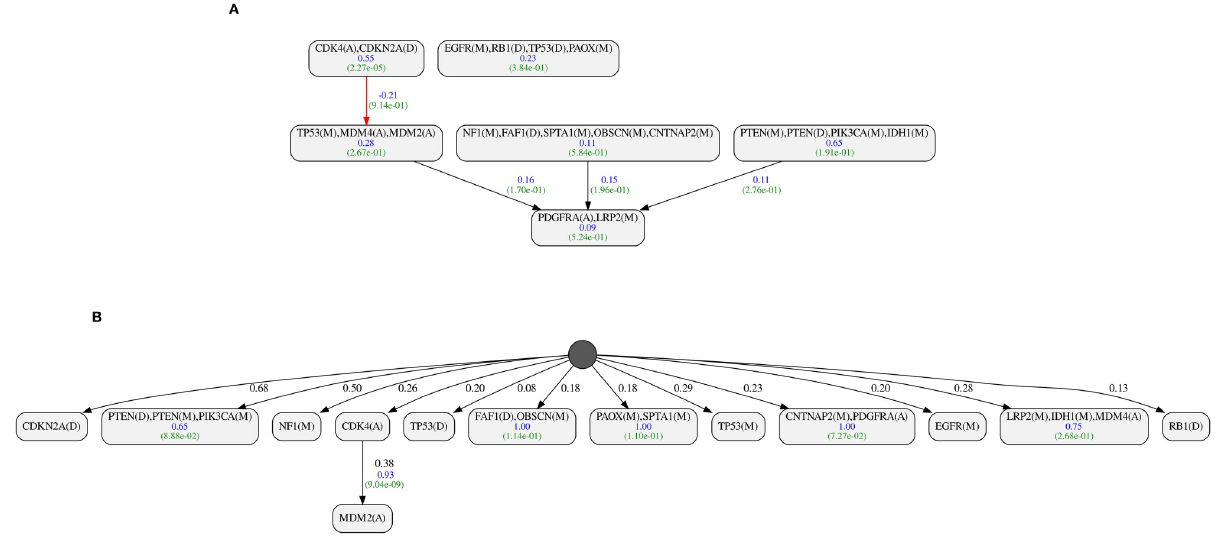
Fig 7. A . PathTiMEx result for the pathTiMEx Glioblastoma dataset. B . ToMExO result for the pathTiMEx Glioblastoma dataset.